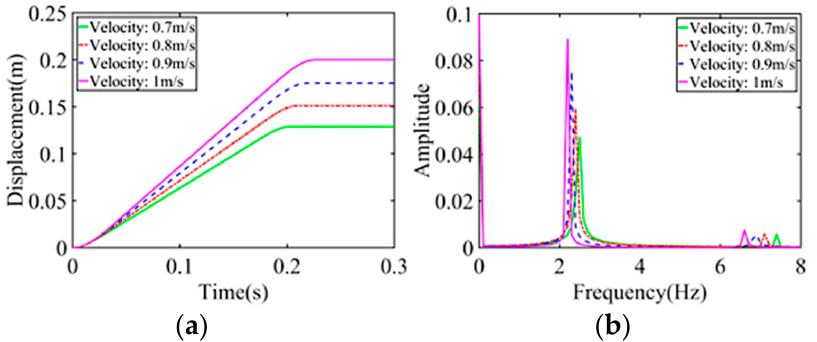
Figure 11. Calculated amplitude spectrum of different velocities under the same acceleration (50 m/s 2 ): ( a ) displacement comparison; ( b ) amplitude spectrum comparison. Table 1. Comparison of calculated theoretical and experimental peak voltages.